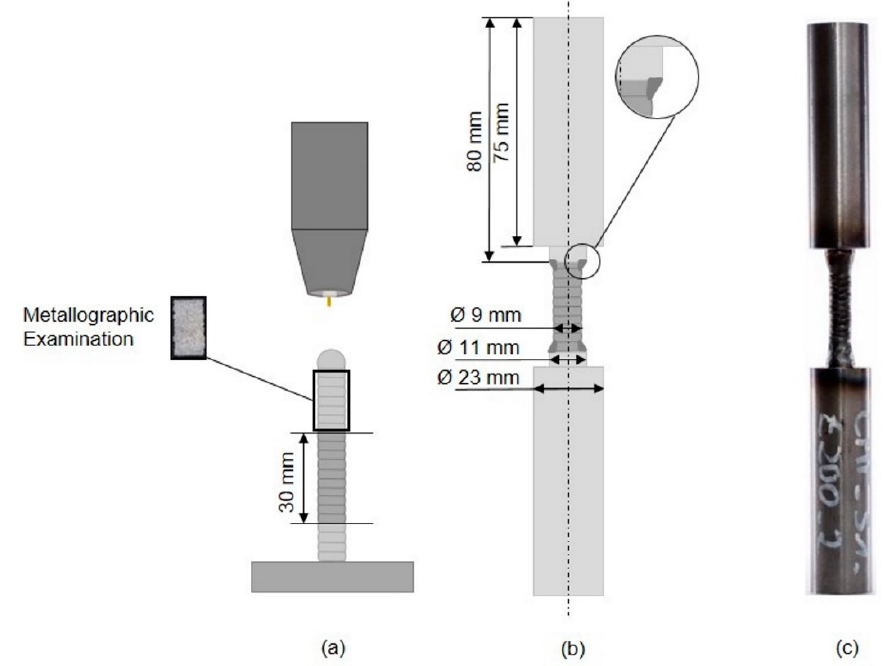
Figure 3. Schematic of the specimen preparation: ( a ) Welding the bar, ( b ) specimen preparation for